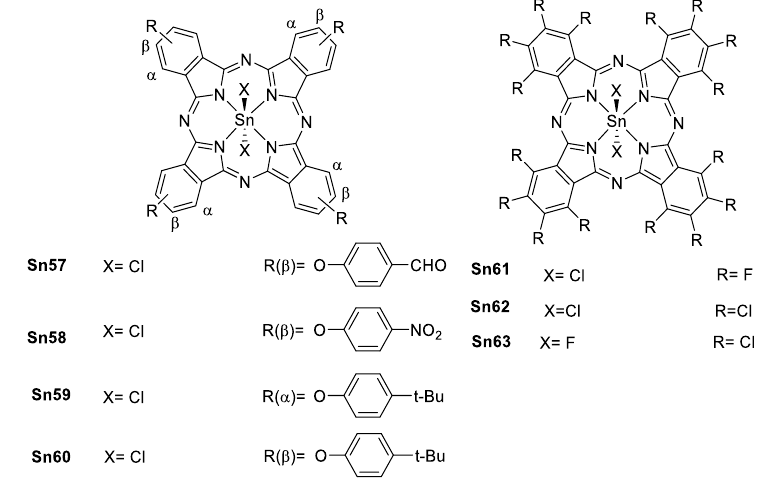
Figure 51. α- and β- substituted tin(IV) phthalocyanines. Figure 51. α - and β - substituted tin(IV) phthalocyanines. Table 7. β , Im{ χ (3) } and the ratio σ Ex / σ g for some